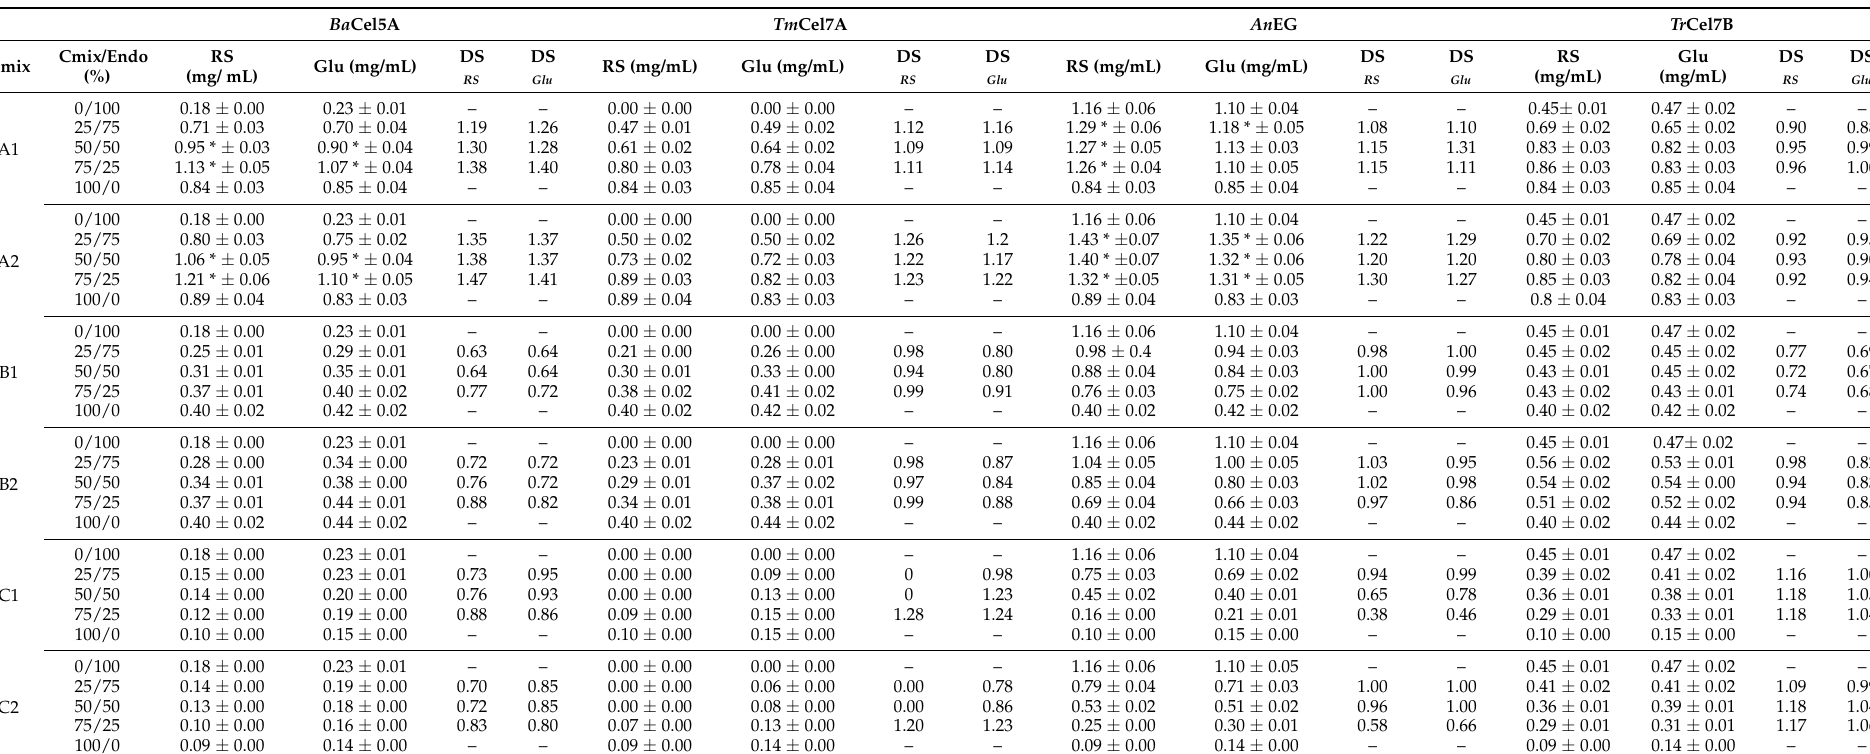
Table 2. Summary of the reducing sugars (RS) and glucose (Glu) released after 24 h hydrolysis of Avicel by the synergistic action of cellulases from different GH families and microbial